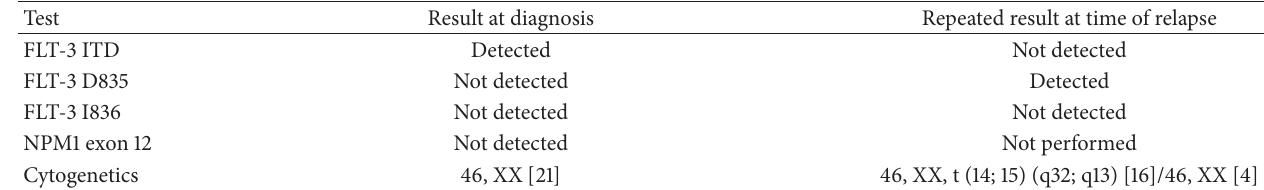
Table 1: Molecular and cytogenetic test results at initial diagnosis and at time of